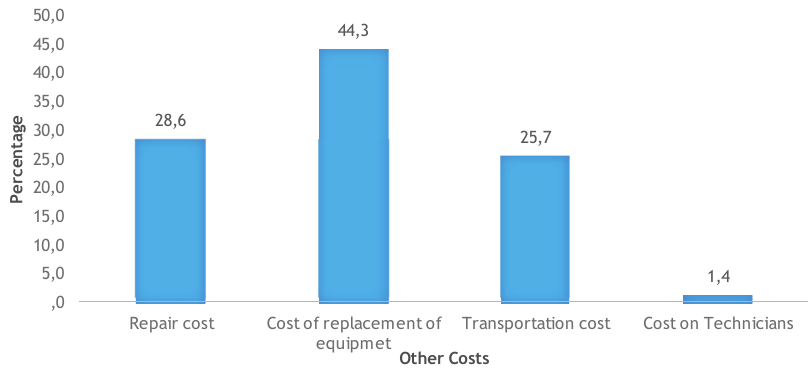
Fig. 4 - Sundry costs incurred on alternate source of power. Source: Survey data,